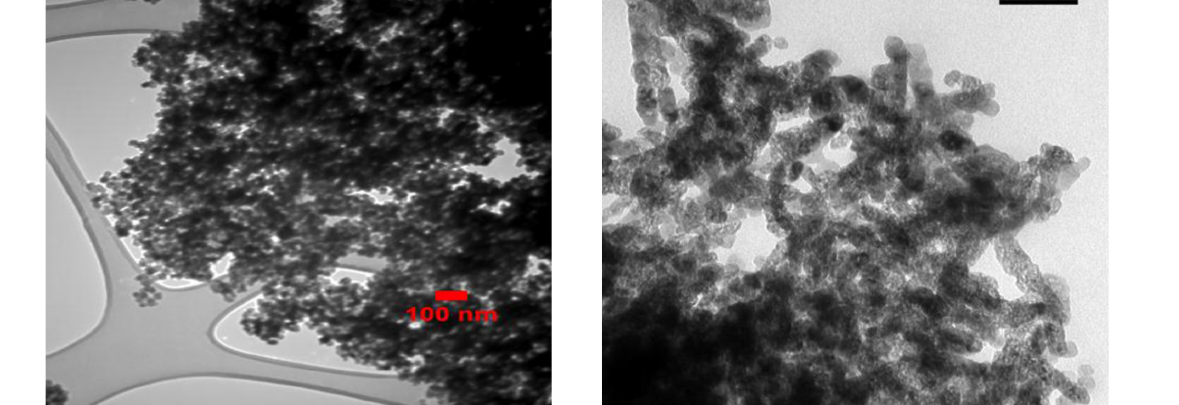
Fig 1. TEM image of nano SiO